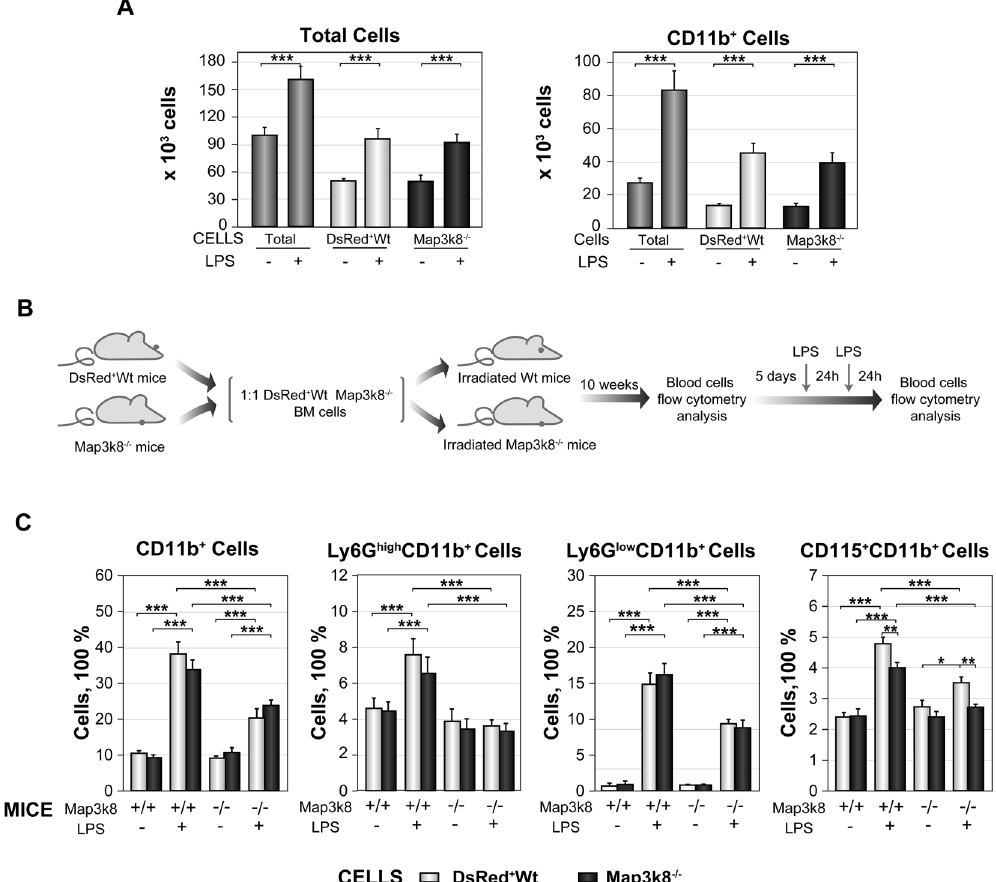
Figure 6. LPS-induced emergency granulopoiesis requires Map3k8 expression in non-haematopoietic cells. ( A ) Isolated BM LIN − cells from DsRed + Wt and Map3k8 − / − mice were mixed at a 1:1 ratio and used to seed the same MethoCult M3434 plate. Cells were incubated with or without LPS (500 ng/ml) for six days. Total, DsRed + (Wt) and DsRed − (Map3k8 − / − ) cells were gated and quantified by flow cytometry. The left panel shows the distribution of total cells, and the right panel shows the distribution of CD11b + myeloid cells. Data were obtained from two different experiments performed in quadruplicate, and statistical significance is indicated for differences between DsRed + Wt and Map3k8 − / − cells with and without LPS treatment only. ( B ) Diagram of the mixed chimaera approach and LPS treatment. ( C ) Circulating DsRed + Wt and Map3k8 − / − CD11b + myeloid cells, Ly6G high CD11b + mature and Ly6G low CD11b + immature neutrophils, and CD11b + CD115 + monocytes from Wt and Map3k8 − / − recipient chimaeric mice were analysed before (LPS − ) and after (LPS + ) LPS treatment. The frequency of the various cells relative to the total number of circulating cells is illustrated ( n = 8). Statistical significance is shown for differences between the DsRed + Wt and Map3k8 − / − cell types from Wt and Map3k8 − / − recipient mice and between the experimental conditions for Wt and Map3k8 − / − recipient mice. ( A , C) DsRed was used to distinguish Wt and Map3k8 − / − cells through the use of an extra gate, DsRed versus FSC-A, identifying Wt cells as DsRed + and Map3k8 − / − cells as DsRed − cells. The data are presented as the mean ± SEM. One-way ANOVA with Newman-Keuls correction was used to compare groups. * p < 0.05, ** p < 0.01, *** p <